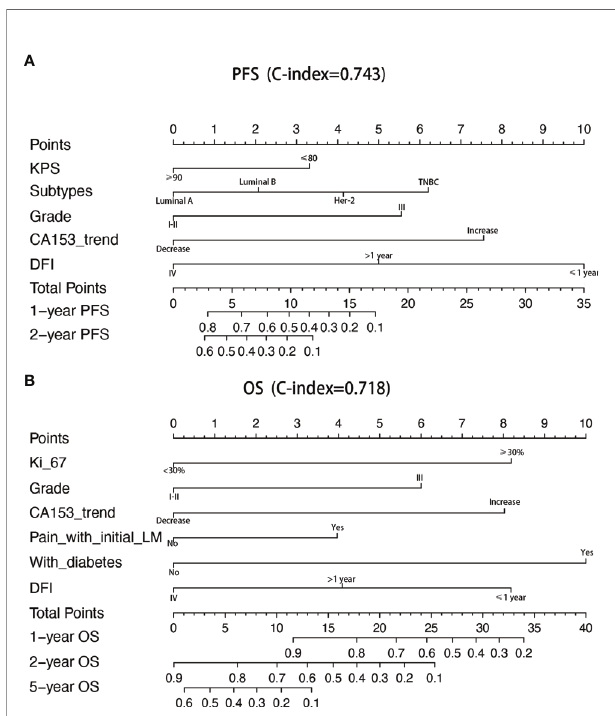
FIGURE 3 | Nomograms of prognosis for patients with LM. (A) The nomogram of prognosis for patients with PFS (C-index = 0.743). (B) The nomogram of prognosis for patients with OS (C-index =